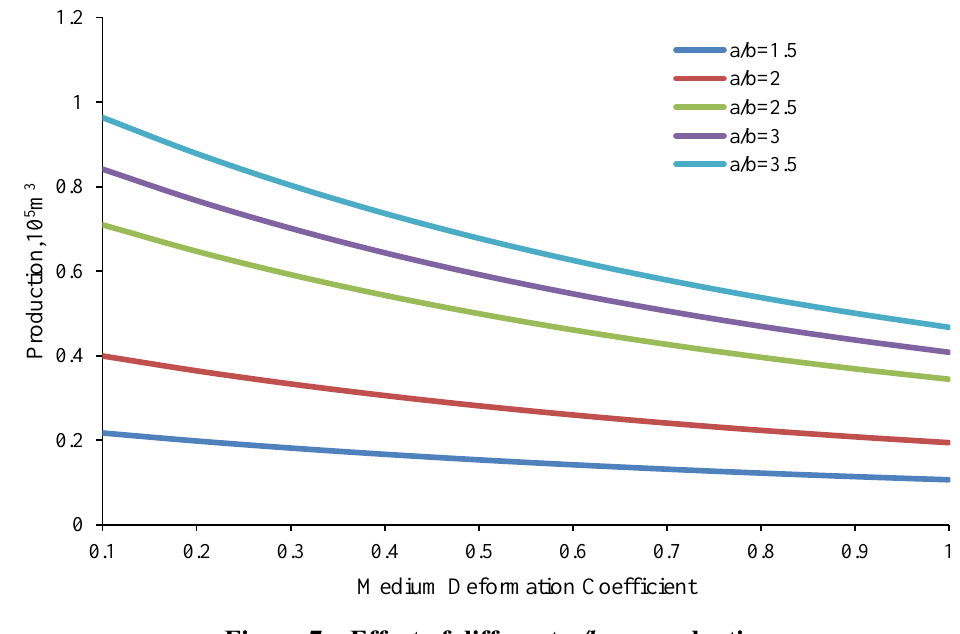
Figure 7—Effect of different a/b on